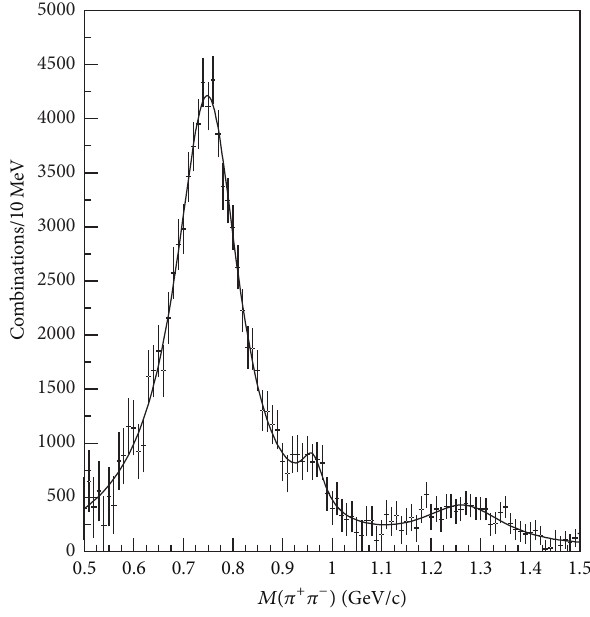
Figure 13: Distribution of the 𝜋 + 𝜋 − invariant mass showing evi- dences for 𝜌 0 (770), 𝑓 0 (980), and 𝑓 2 (1270) production after back- ground